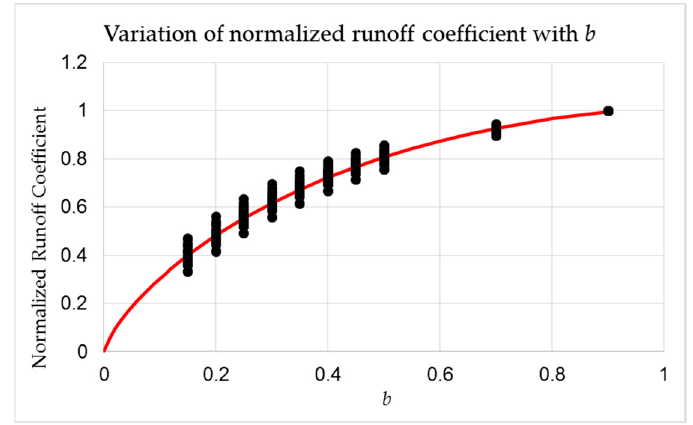
Figure 5. Variation of normalized runoff coefficient with the b parameter. The black circles are data points from the sensitivity analysis and the solid red line is a Hoerl model trendline fitted to the data.